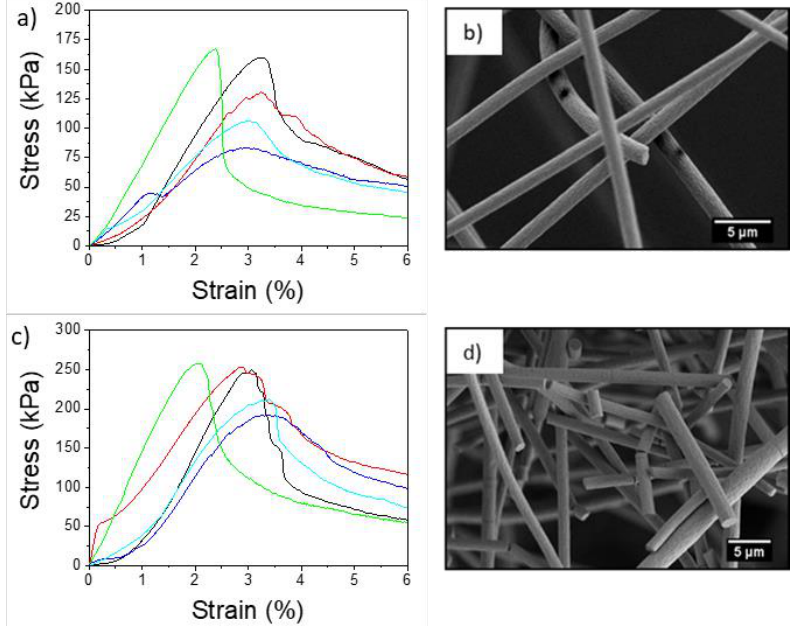
Figure 6. Stress-strain curves and scanning electron microscopy (SEM) images obtained after tensile tensile testing of random PMMA fiber mats produced with a positively ( a , b ) versus negatively testing of random PMMA fiber mats produced with a positively ( a ), ( b ) versus negatively ( c ), ( d ) ( c , d ) charged charged spinneret.